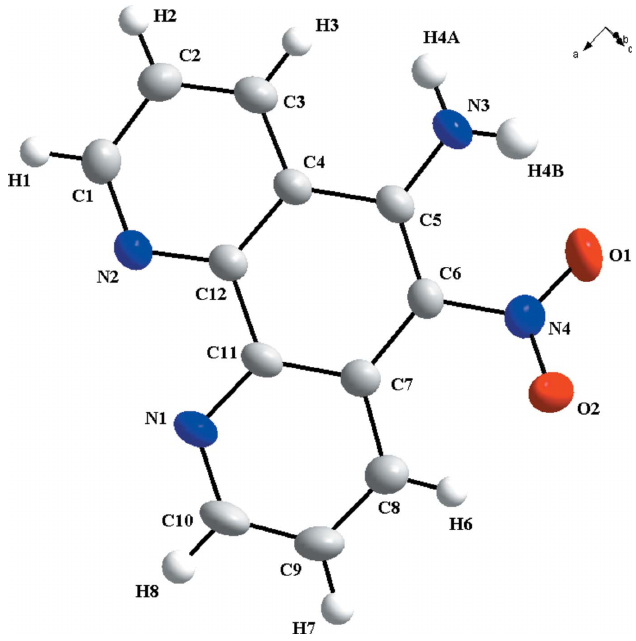
Figure 1 The molecular structure of the title compound showing 50% displace- ment ellipsoids.